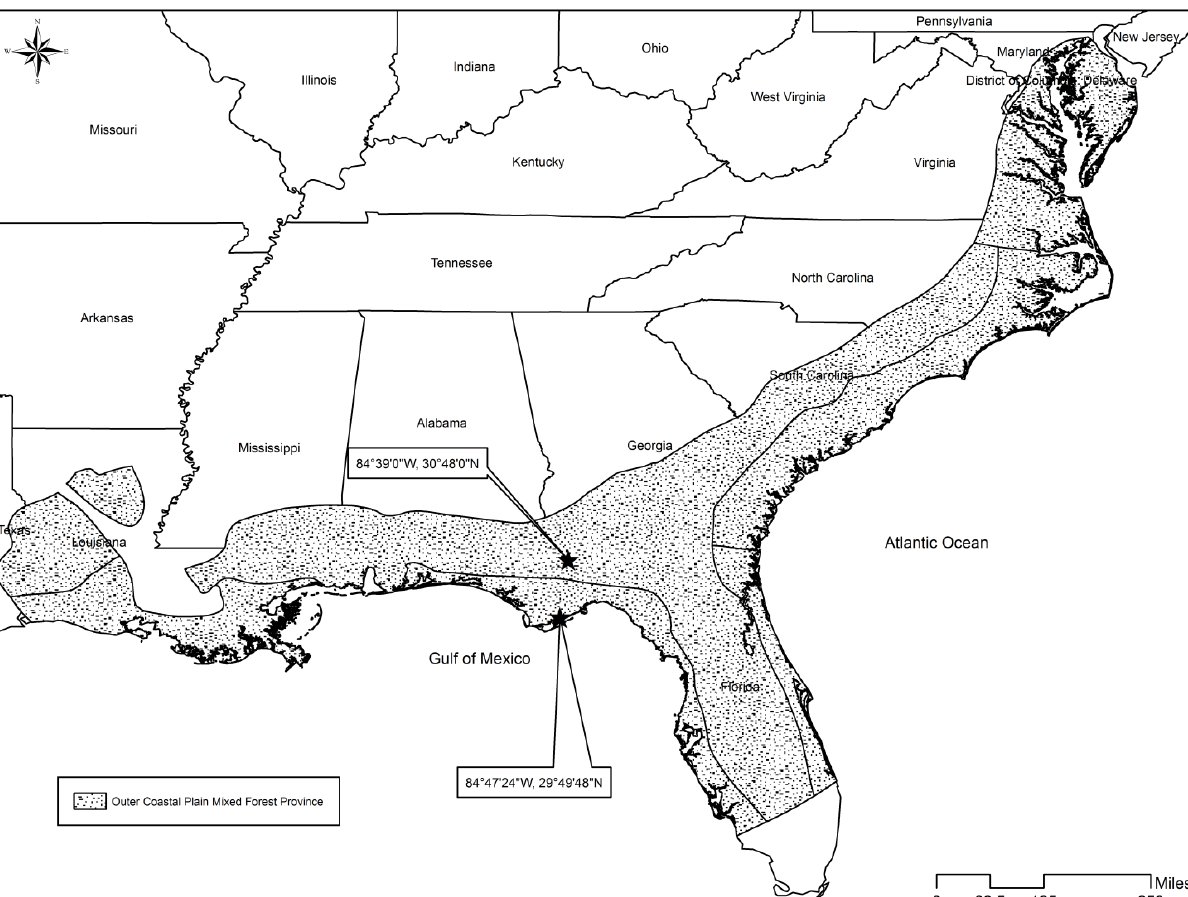
Figure 1. Map showing the coastal plain (shaded area) of the southeastern USA where studies that provided data to model herbaceous richness were conducted. Stars indicate two of the sites (Georgia and Florida) that provided data to validate herbaceous richness